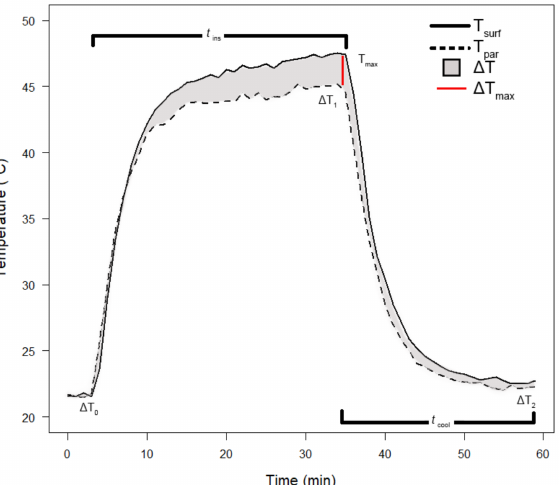
Figure 6. Representative run of the thermal insulation test. We defined insulation strength ( ∆ T) as the difference between the temperatures of the velamen surface (T surf ) and the outermost layer of the living tissue (T par ), the maximal difference being ∆ T max . We determined the period of heating (t ins , infrared light switched on until ∆ T 1 was reached) and the period of cooling (t cool , infrared light switched off until ∆ T 2 was reached). At the start of t ins , the temperature difference was minimal ( ∆ T o ), and typically maximal ( ∆ T 1 ) at the end of t ins with a stable maximal temperature (T max ). The test ended when the curve flattened again after switching off the light source. At that point, the temperature difference ( ∆ T 2 ) was again very small but usually larger than at the beginning ( ∆ T o